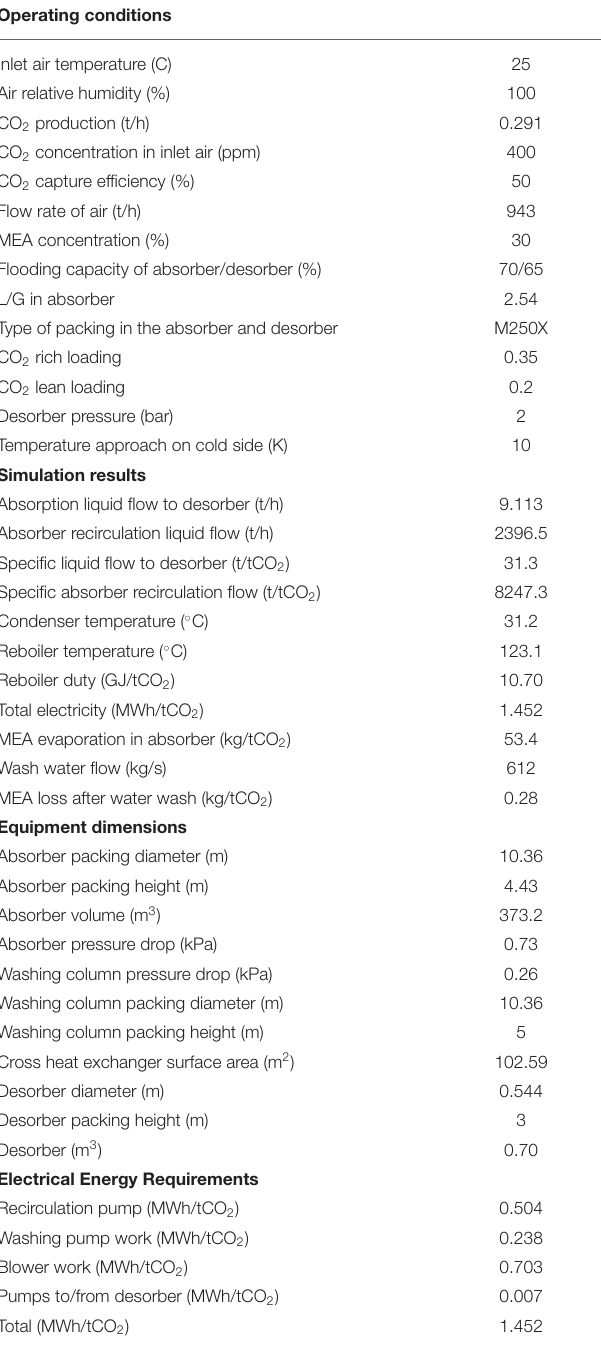
TABLE 3 | The operating conditions and process simulation results for a base case scenario in the air capture process. Operating conditions